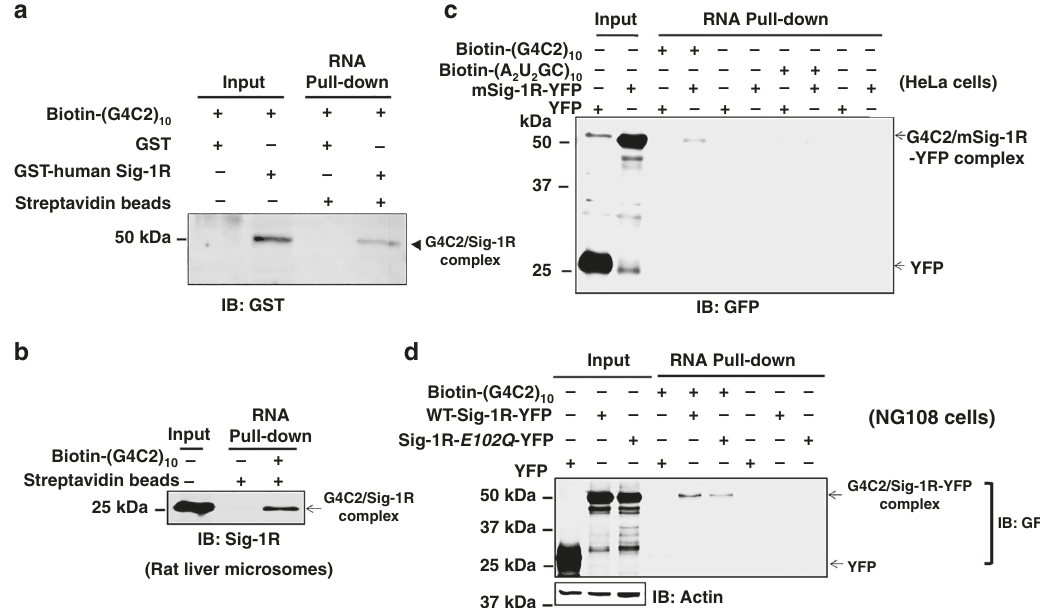
Fig. 4 Human Sig-1R interaction with (G4C2) 10 -RNA: direct binding assay with puri fi ed molecules in the in vitro cellular assay. a Puri fi ed human sigma- 1 receptor (Sig-1R) directly binds (G4C2) 10 -RNA in a chemical reaction in test tube. The biotin pull-down assay plus western-blot analysis were performed to detect the association of biotin-labeled (G 4 C 2 ) 10 -RNA and GST-tagged human Sig-1R. b (G4C2) 10 -RNA binds the endogenous Sig-1R in rat liver microsomal preparation. Biotin-labeled (G4C2) 10 -RNA was incubated with lysates from rat liver microsomes followed by the biotin pull-down assay plus western-blot to detect the association of biotin-labeled (G 4 C 2 ) 10 -RNA and endogenous Sig-1R. c Scrambled RNA repeats failed to bind Sig-1R. Biotin- labeled (A 2 U 2 GC) 10 -RNA was chosen as the scrambled RNA control. HeLa cells were transfected with mouse Sig-1R-YFP (mSig-1R-YFP) vectors for 24 h before the biotin pull-down assay plus western blot. Note: compare lane 4 vs lane 8. d Sig-1R mutation from glutamic acid to glutamine at amino acid 102 (i.e., Sig-1R-E102Q) has a lower af fi nity for (G4C2) 10 -RNA. NG-108 cells were transiently transfected with wild-type human Sig-1R-YFP or Sig-1R-E102Q- YFP vector for 24 h before the biotin pull-down assay plus western blot. Note: compare lane 5 vs lane 6. Sig-1R, Sigma-1 receptor. n = 4 ( a ), n = 3 ( b ), n = 3 ( c ), and n = 3 ( d ) independent experiments with similar results from biologically independent cellular preparations.